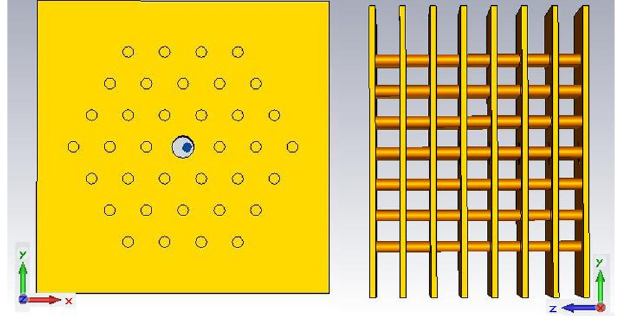
FIG. 1. Schematic of a seven-cell PBG structure. The structure is formed by three rows of a triangular lattice of metallic cylindrical rods. The central rod is removed to form a defect region to confine the fundamental TM 01 mode. The dimensions are given in Table